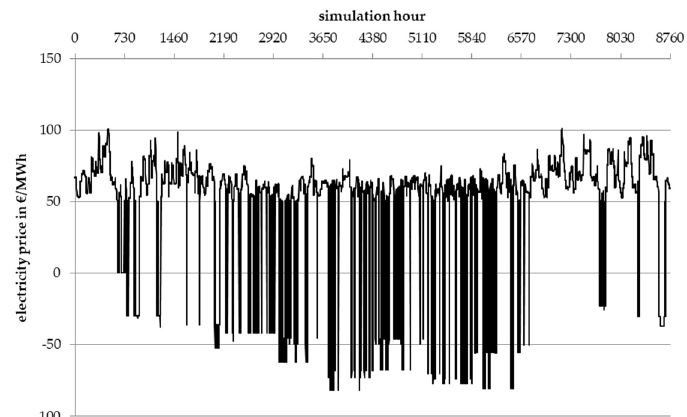
Figure A5. Market prices for one year in the extended storage scenario.